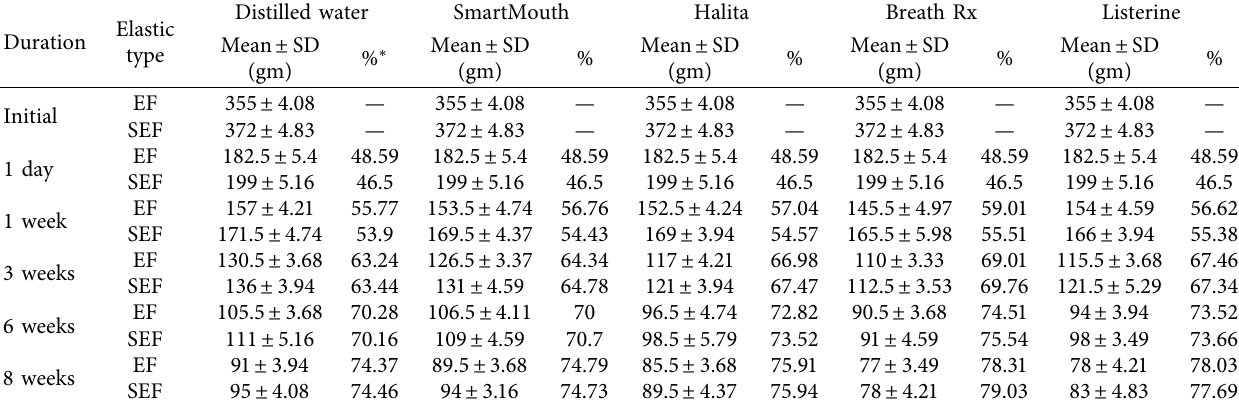
Table 2: Mean, SD, and percentage of force degradation of the force generated by Elasto-Force and Super Elasto-Force elastomeric chains treated with different chemical solutions.